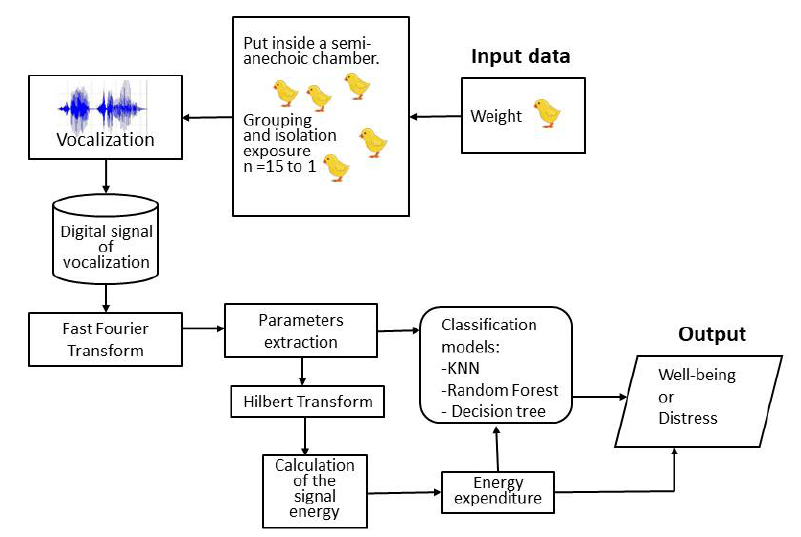
Figure 2. The schematic view of the vocalization signal processing.